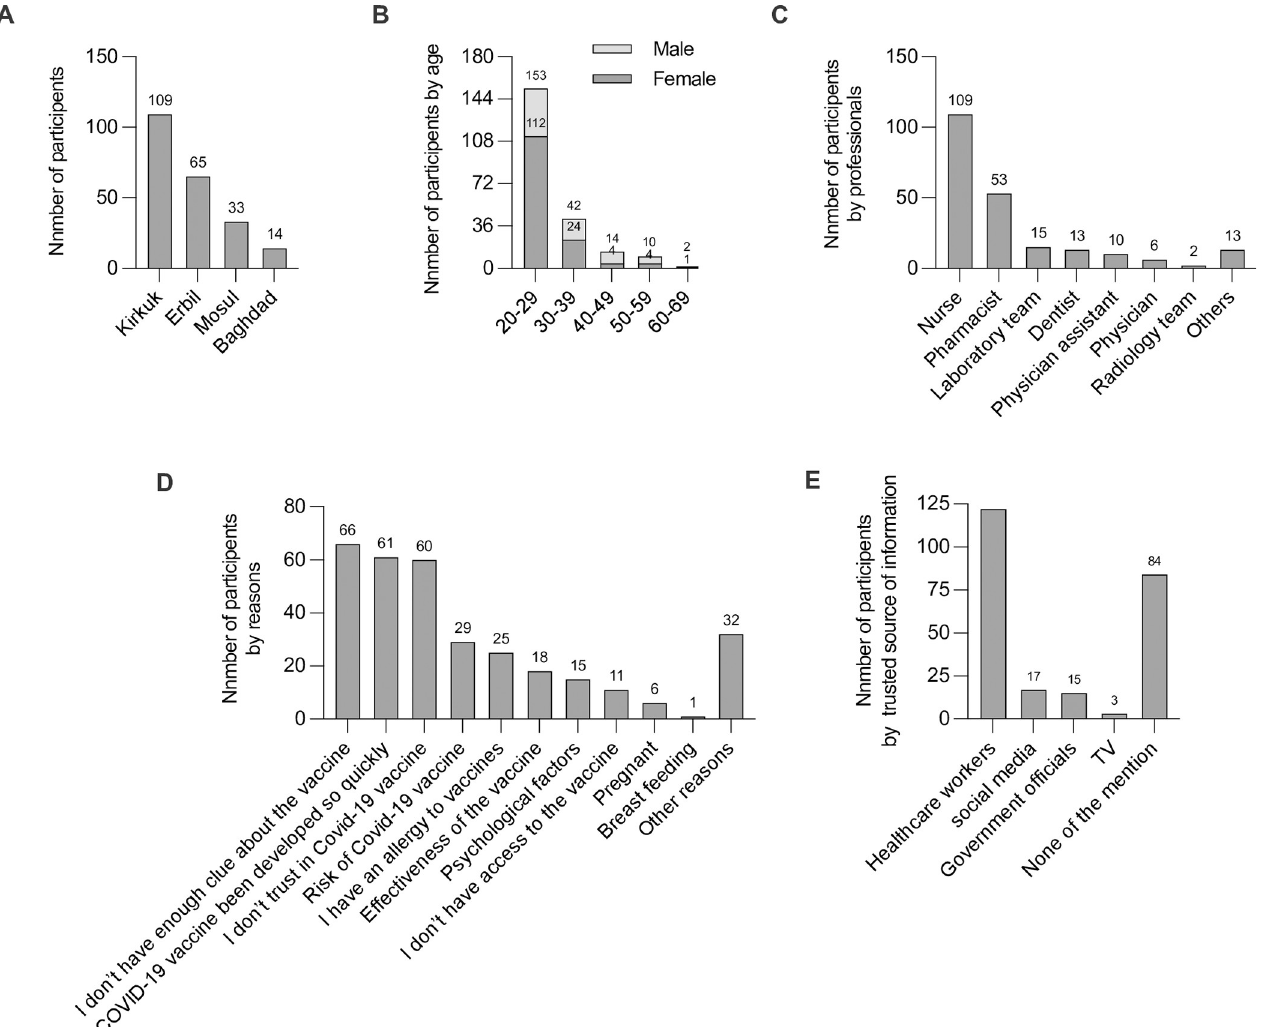
Fig 6. Characteristics of vaccine-hesitant participants. (A) Number of vaccine-hesitant participants by counties, (B) number of vaccine-hesitant participants by age groups, (C) number of vaccine-hesitant participants by professionals, (D) number of vaccine-hesitant participants based on reasons of rejecting the vaccines, (E) number of vaccine-hesitant participants based on source-trusted information about the vaccines.